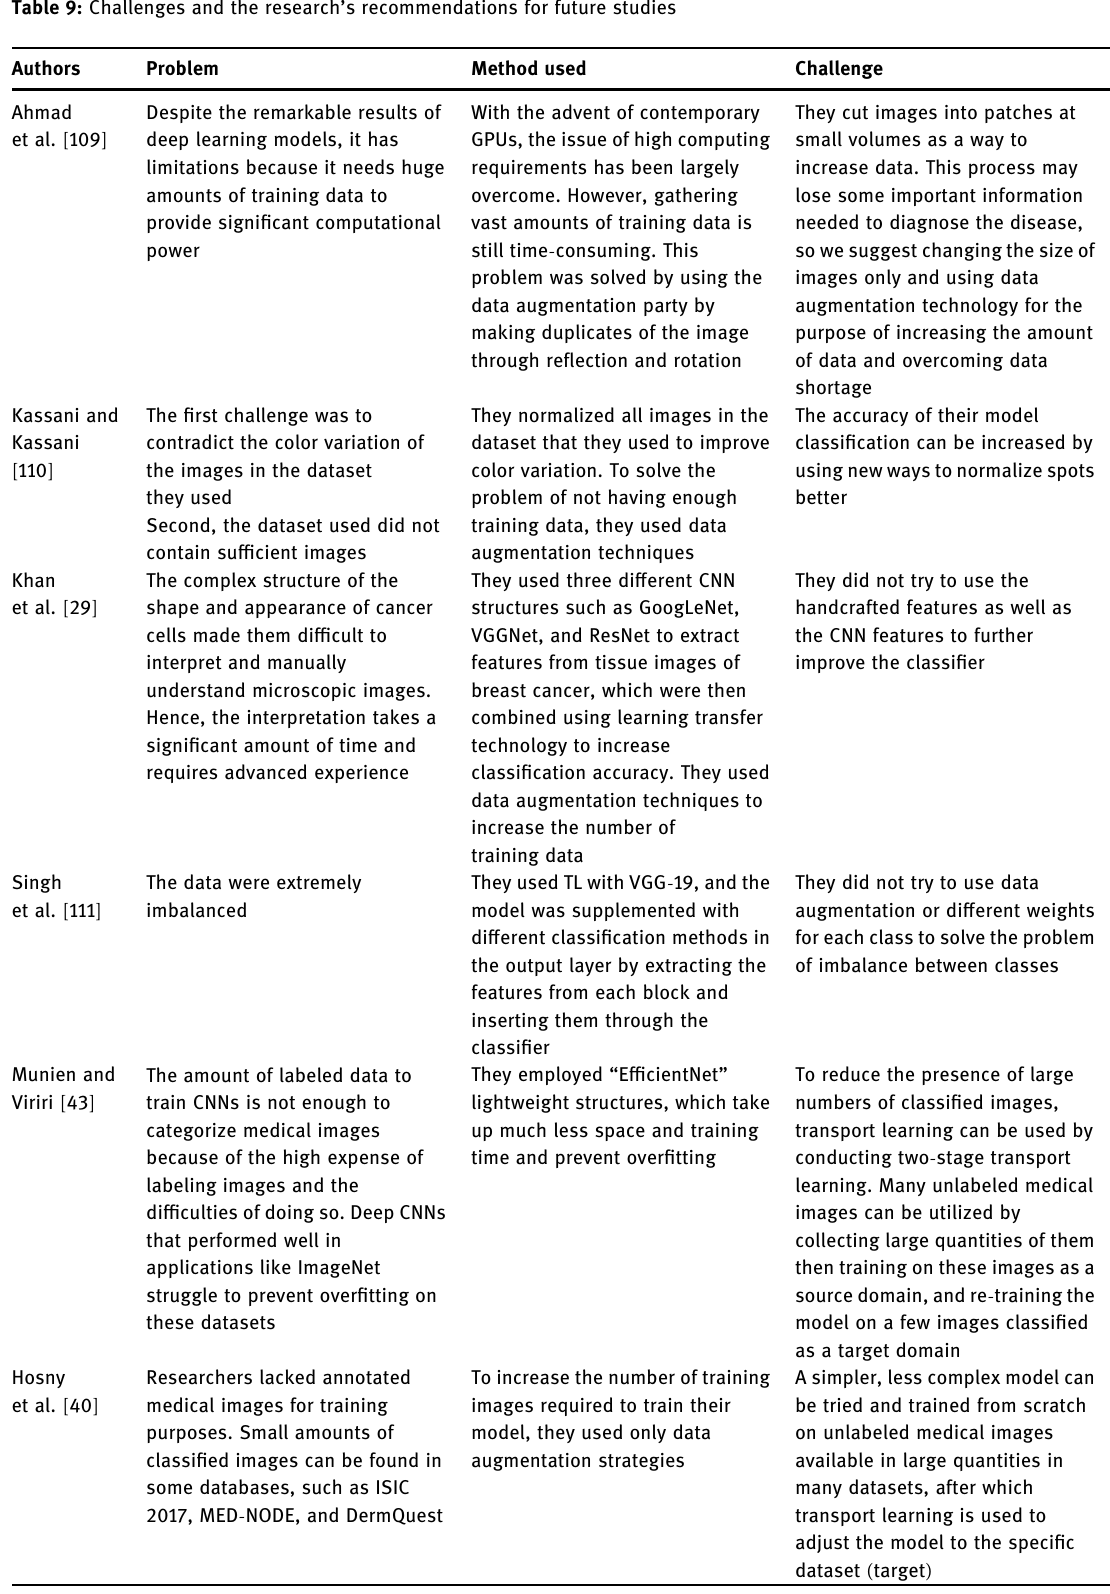
Table 9: Challenges and the research ’ s recommendations for future studies